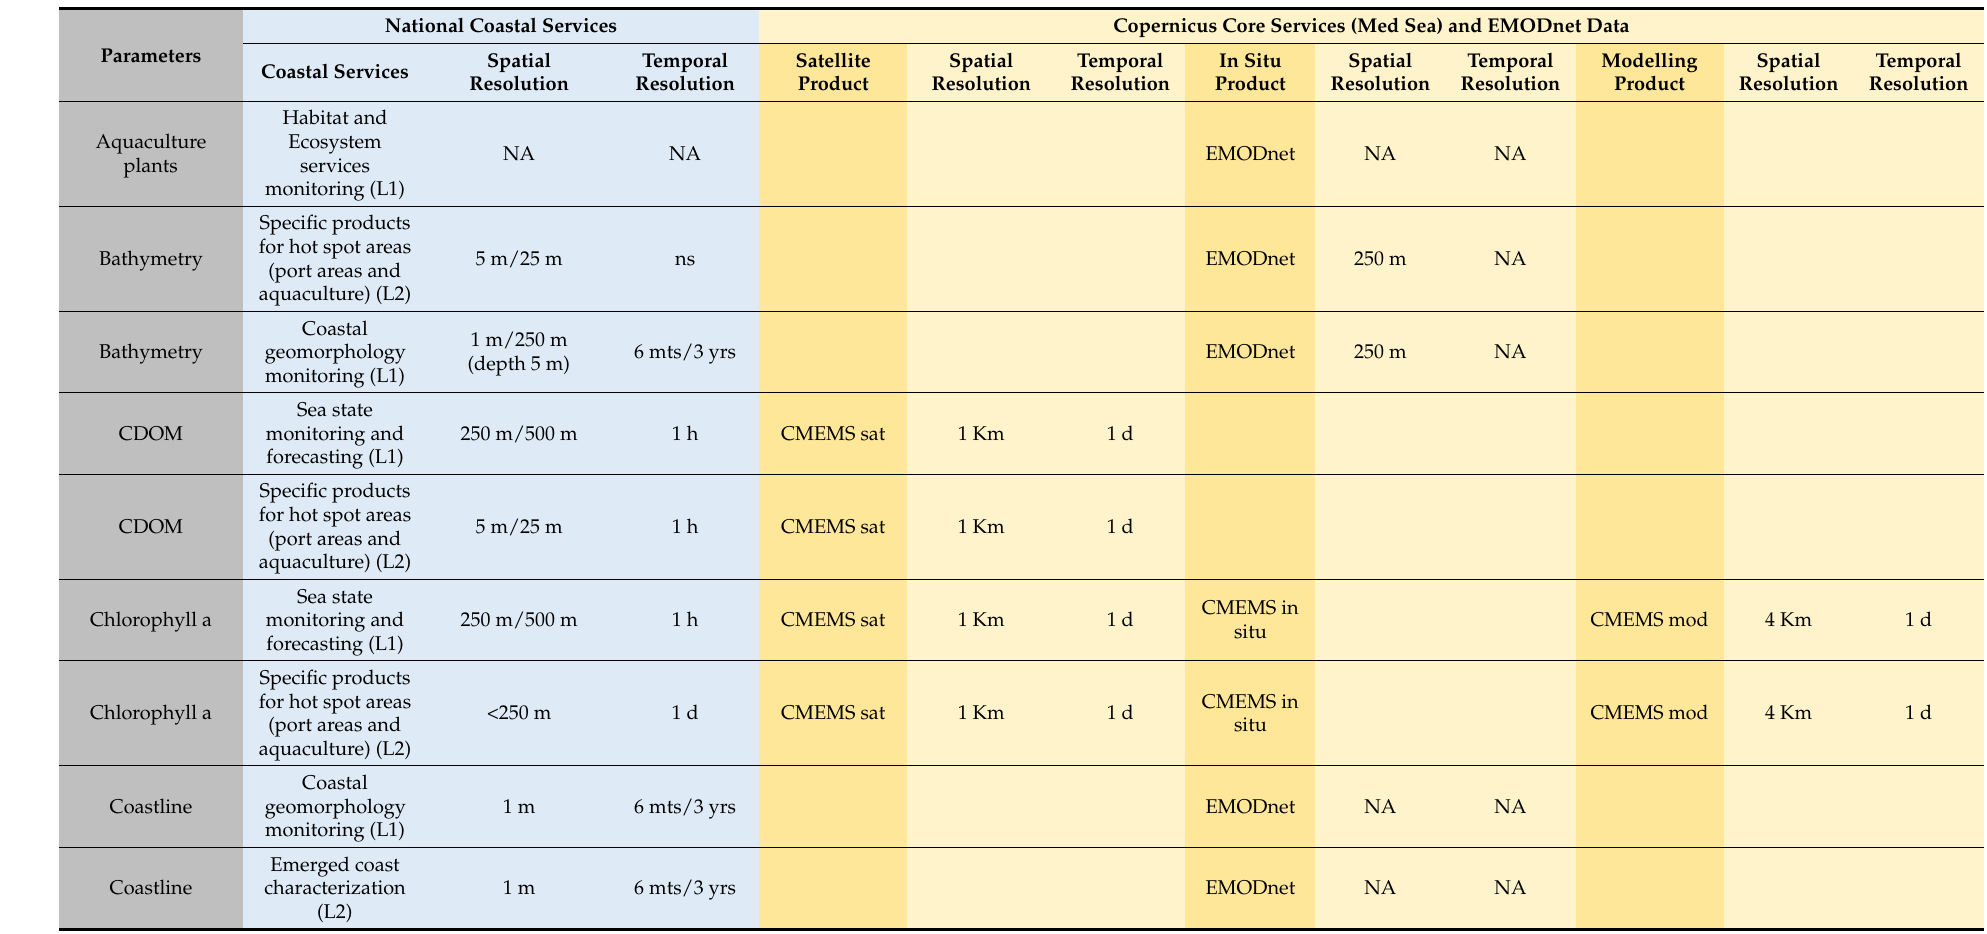
Table 4. Comparison between spatial and temporal resolution required for national coastal services and provided by Copernicus Core services and EMODnet